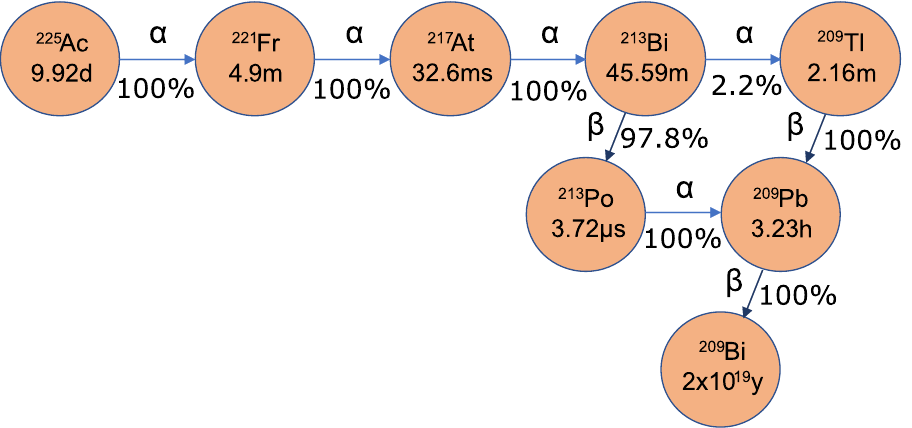
Figure 1. 225 Ac decay scheme. Half-lives of the isotopes are indicated in the circles, and decay modes and branching ratios are indicated along the